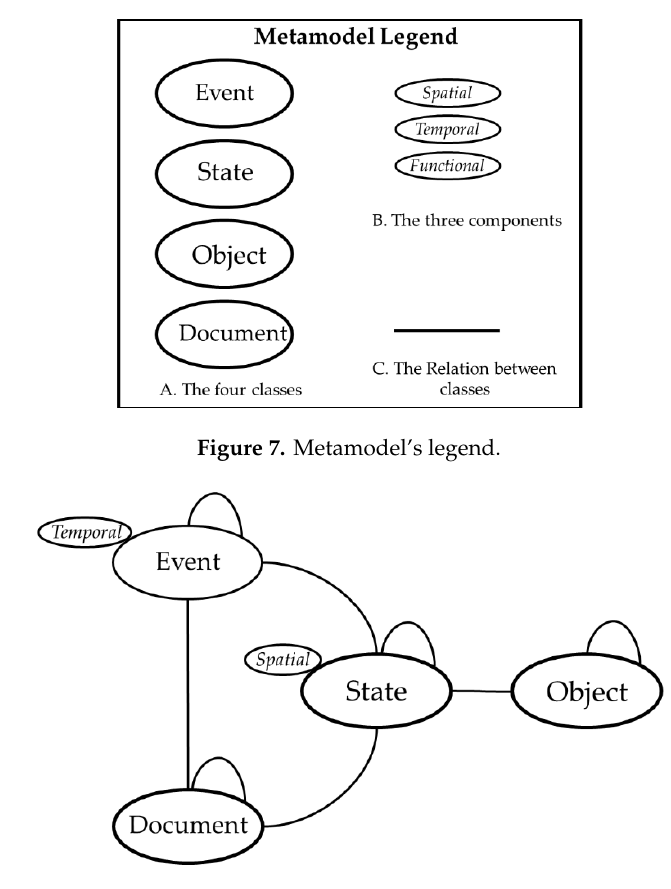
Figure 8. The simplified version of the metamodel adopted for the Coudenberg project.